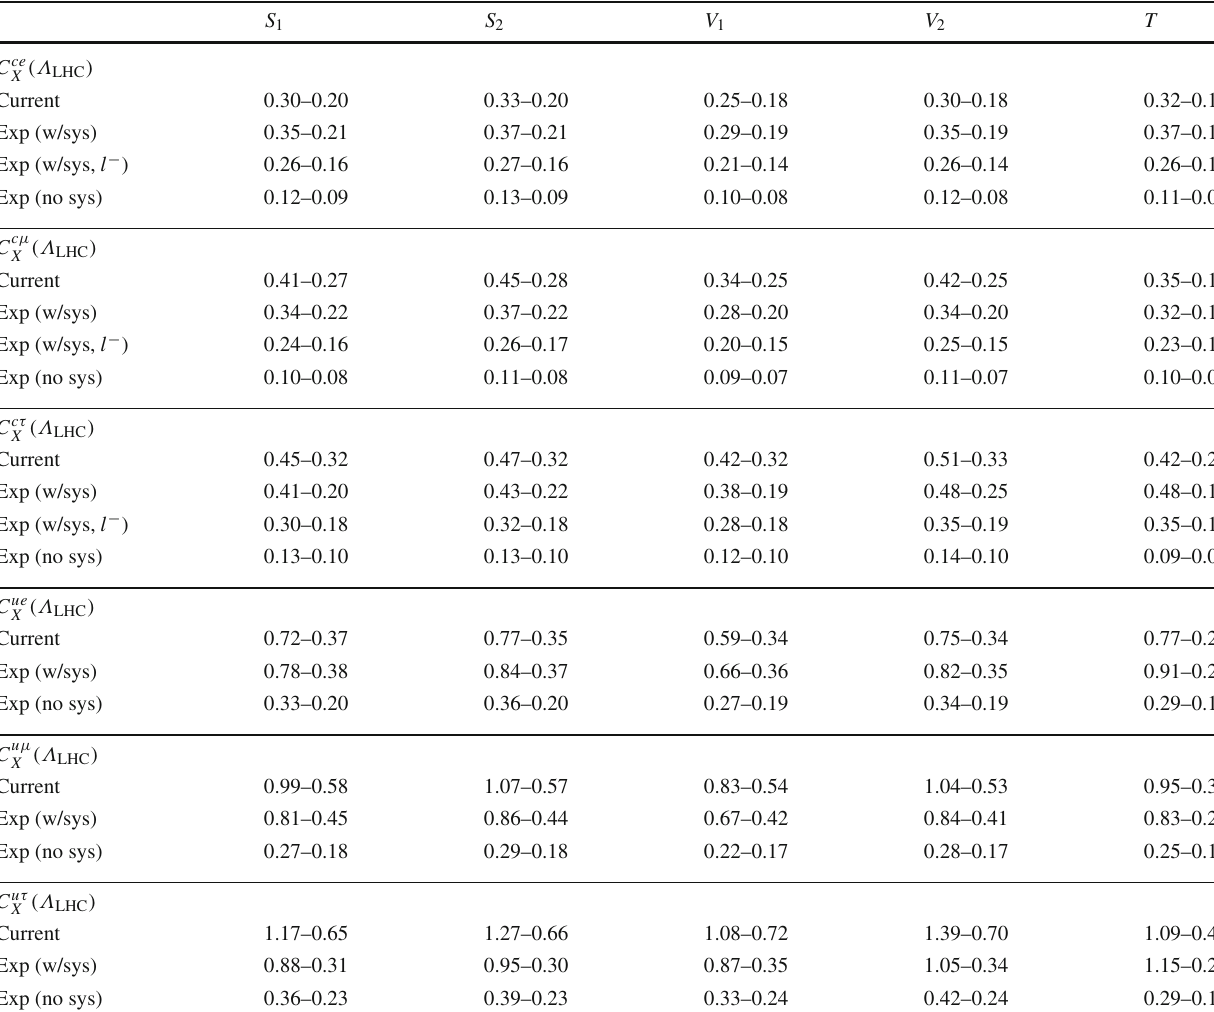
Table 2 Summary of the current LHC bounds with 139 fb − 1 / 35 . 9 fb − 1 for the (cid:6)/τ modes, and the future HL-LHC potential with 3 ab − 1 , for the LQ cases of the ( 2TeV − 100TeV ) masses. Note that the latter case corresponds to the EFT limit. See the main text for the